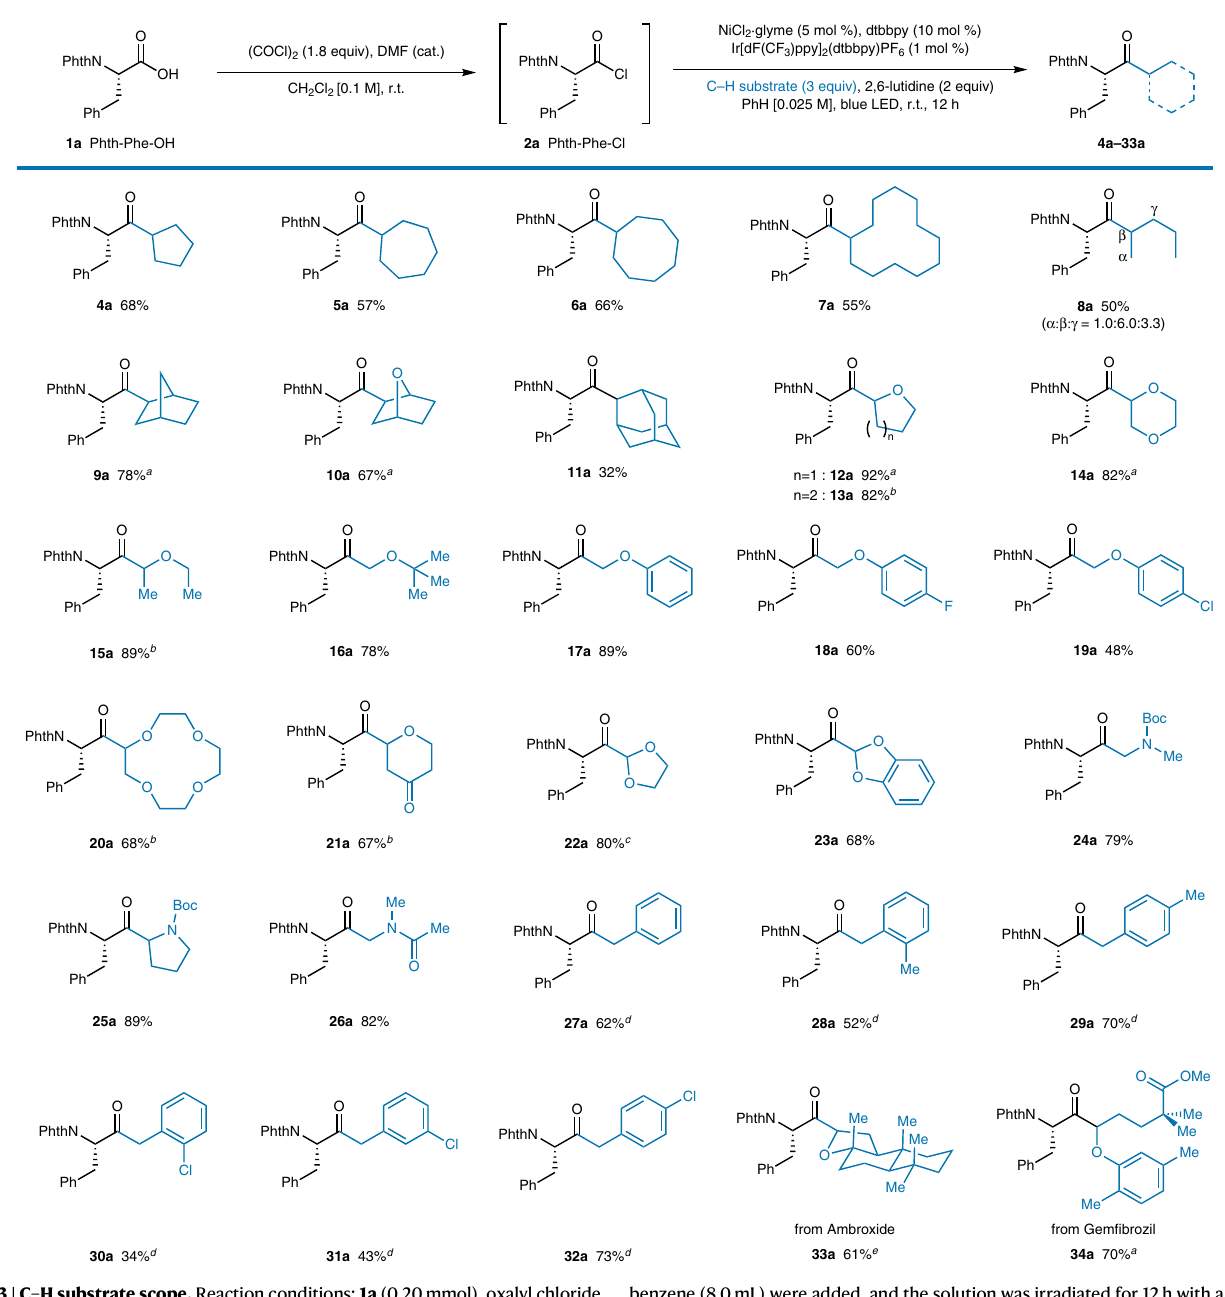
benzene (8.0mL) were added, and the solution was irradiated for 12h with a Penn PhD M2 photoreactor. All yields are isolated yields. a d.r. = 1:1. b d.r. = 2:1. c r.r. = 4:1; d.r. for the minor regioisomer = 1:1. d 10 equiv of C – H substrate. e d.r. =